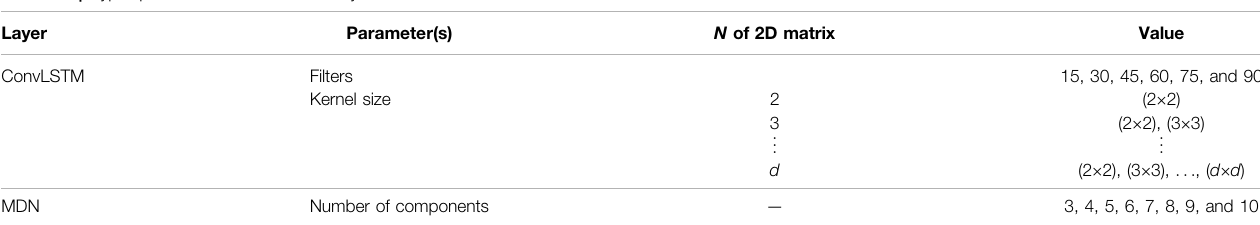
TABLE 1 | Hyper-parameters of ConvLSTM layer and